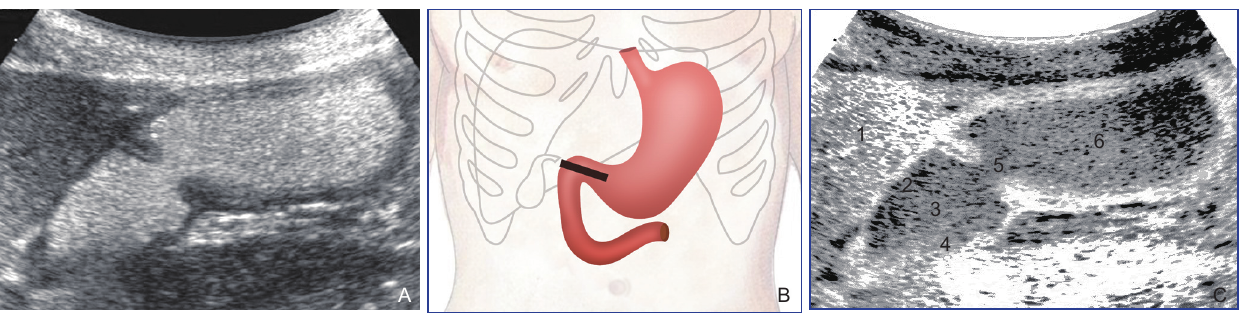
Figure 13 Ultrasonogram and schematic diagram of long axis of gastro-duodenal bulb and ultrasonic image (scan through right upper abdomen). A, Ultrasonogram; B, Schematic diagram; C, Schematic diagram of ultrasound (1, Right liver lobe; 2, Anterior wall of bulb; 3, Duodenal bulb; 4, Posterior wall of bulb; 5, Pylorus; 6, Gastric